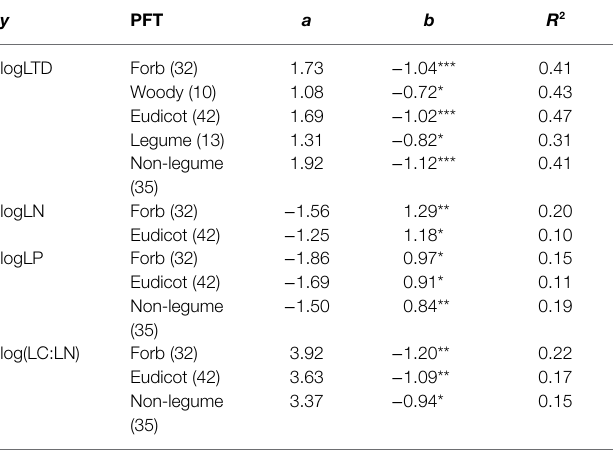
For abbreviations see Table 1 . Symbols a and b represent the intercept and slope of linear regression, respectively, R 2 represents the coefficient of determination. Only significant relationships are shown. Species numbers are included in parentheses.*Indicates significant linear regression at 0.05 confidence